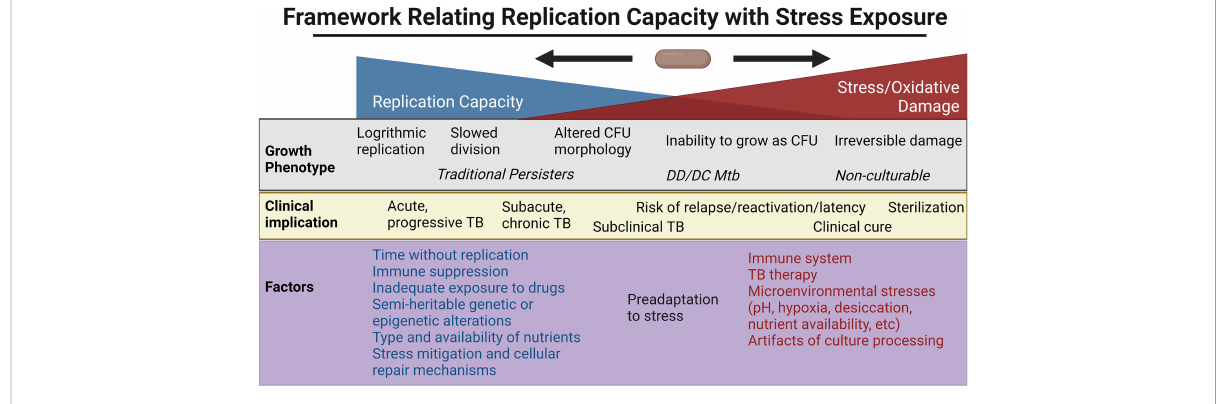
FIGURE 2 Framework for the relationship between replication capacity and stress/oxidative damage, with the related in vitro growth phenotype and in vivo clinical implication placed along the spectrum. Factors favoring increased replication capacity and increased stress are listed below. Created with